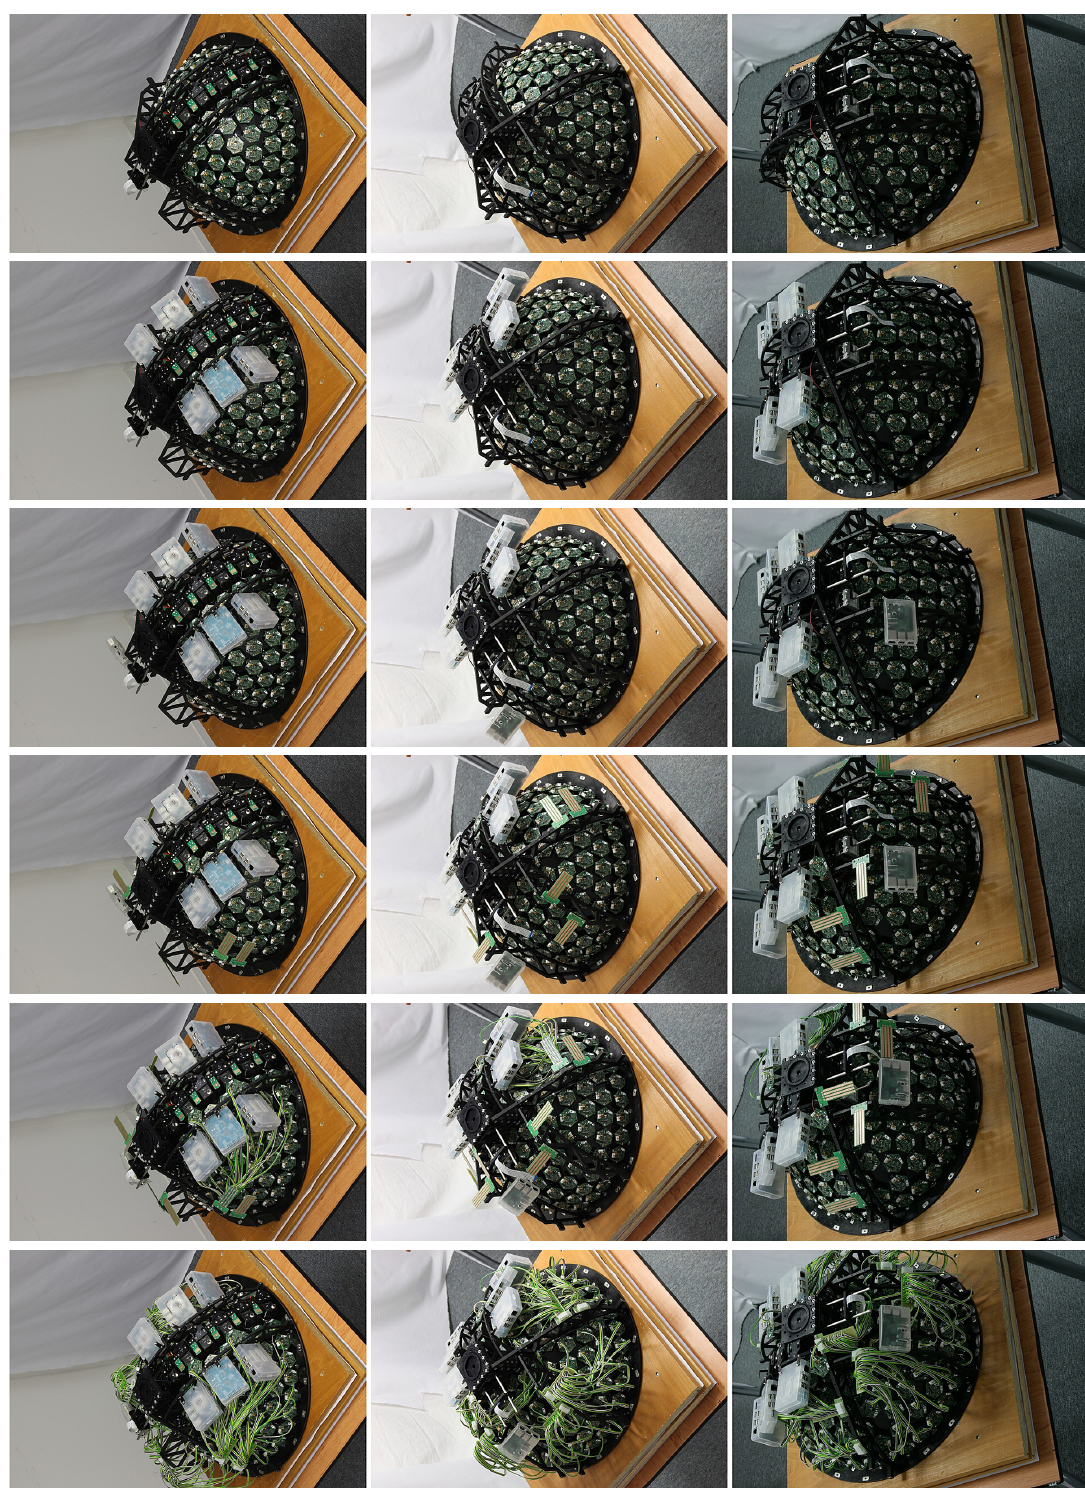
Figure A2. Assembly of lightdrum, step 7 to 12 from three different views. Row 1: mounting auto-collimator; Row 2: populating six microcomputers Hardkernel Odroid-XU3; Row 3: populating the microcomputer Raspberry Pi 2; Row 4: mounting the RS485 bus distribution boards; Row 5: connecting the first distribution board to LED modules; Row 6: connecting eight distribution boards to LED